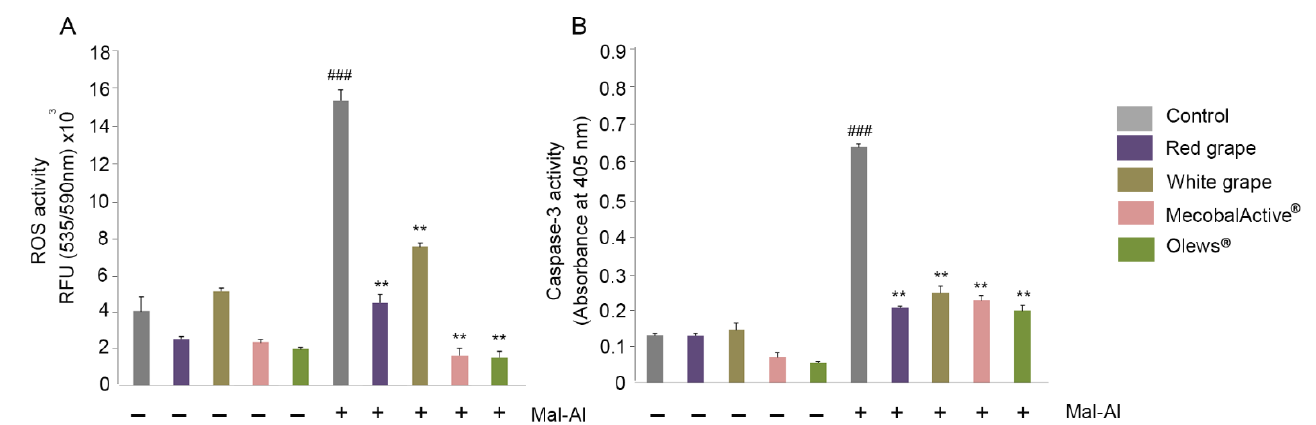
Figure 4. Reactive oxygen species (ROS) levels ( A ) and caspase-3 activity ( B ) on SH-SY 5Y cells after extract treatment. Cells were treated with red grape, white grape, MecobalActive ® , or Olews ® for 48 h in the absence or presence of 125-µM Al(mal) 3 . ROS activity ( A ) was quantified by measuring the fluorescence at 535/590 nm. Caspase-3 activity (B) was quantified by measuring the absorbance at 405 nm. Values are presented as mean ± SEM from at least three independent experiments; Kruskal-Wallis test followed by Mann Whitney post-hoc test were used for statistical analysis. ### p < 0.001 versus untreated cells and ** p < 0.01 versus Al(mal)3. Abbreviations: Mal-Al: Al(mal) 3.